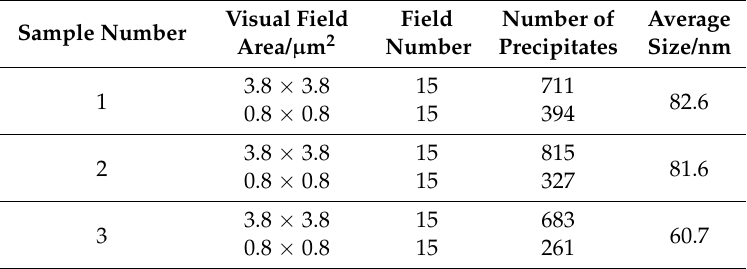
Table 2. Statistics of precipitates at different positions in H13 after